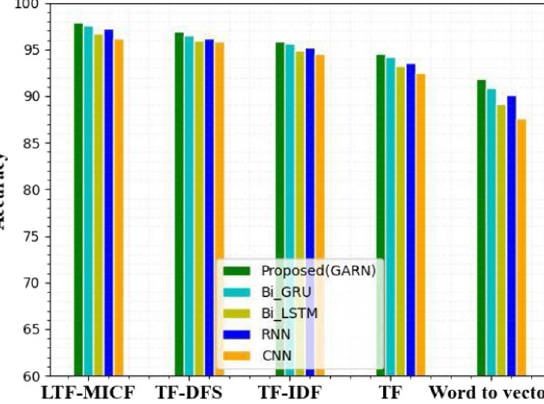
Fig. 4 Accuracy of the classifiers with term weight